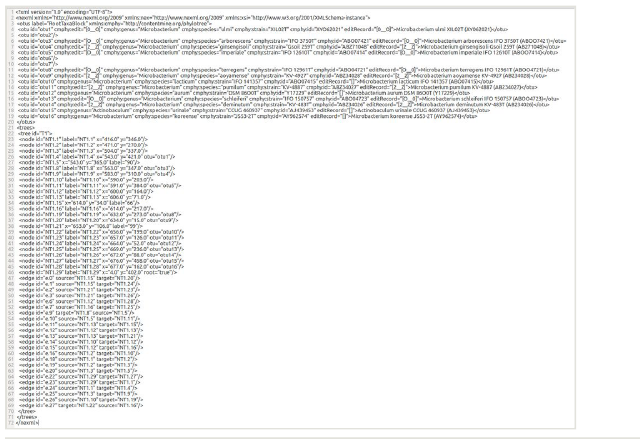
Figure 5. Screenshot of exemplar machine-readable NeXML formatted data output from our automated analysis of the fi gure image from fi gure 1 of Park et al. 2008. Note that the genus, species, strain, and Genbank Accession numbers are semantically distinguished where detected. Heuristic post-OCR autocorrection processes are also noted where these have been applied (e.g. the conversion of a letter 'Z' to the number '2' in many Genbank Accession numbers). A machine-readable version of this fi le is supplied as supplementary material (Suppl. material